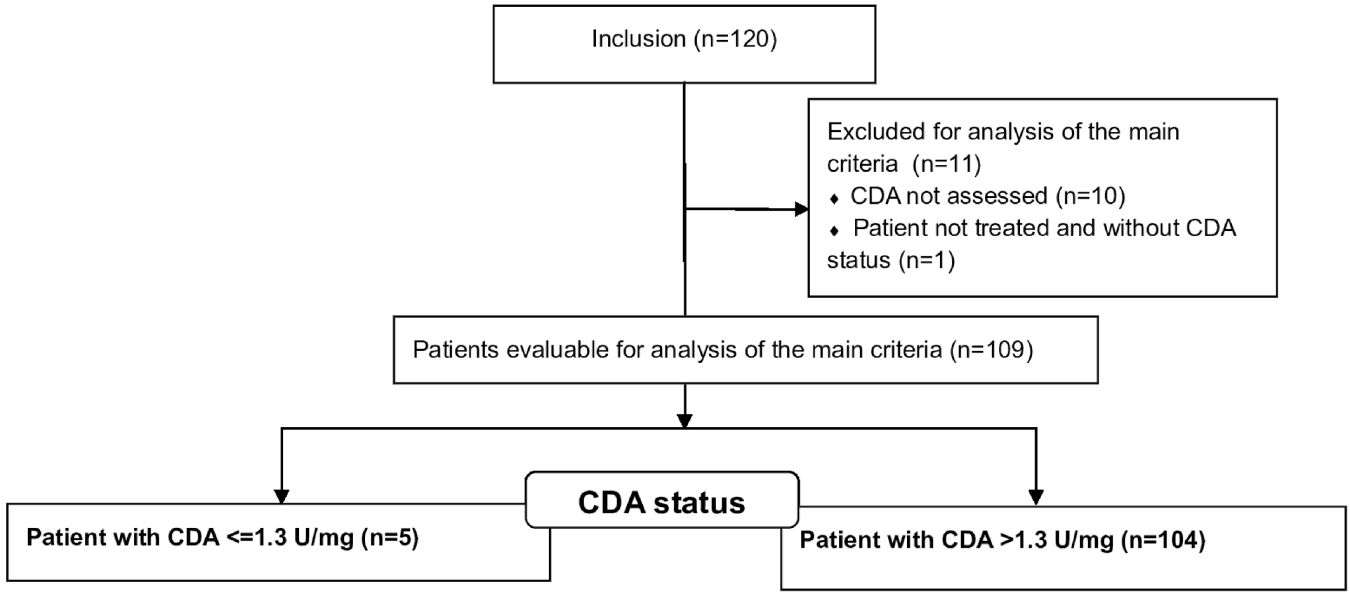
Fig 1. Consort flowchart of the primary objective in the FFCD-1004 clinical trial.